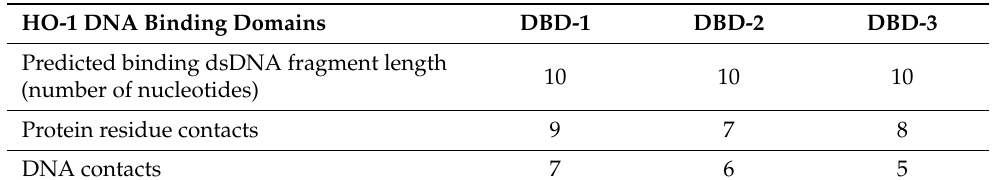
Table 3. Specific dsDNA ‐ peptide contact positions within each HO ‐ 1 DNA binding domain.